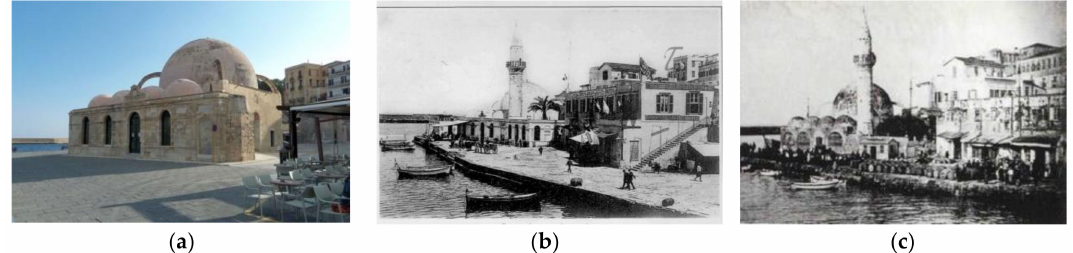
Figure 1. ( a ) The Ottoman Glass Mosque in its current state on the left (author’s picture). Its original state in the middle ( b ) and on the right ( c ). Image ( b ) comes from G. Despotaki’s archive and image ( c ) from M. Manousaka’s archive.